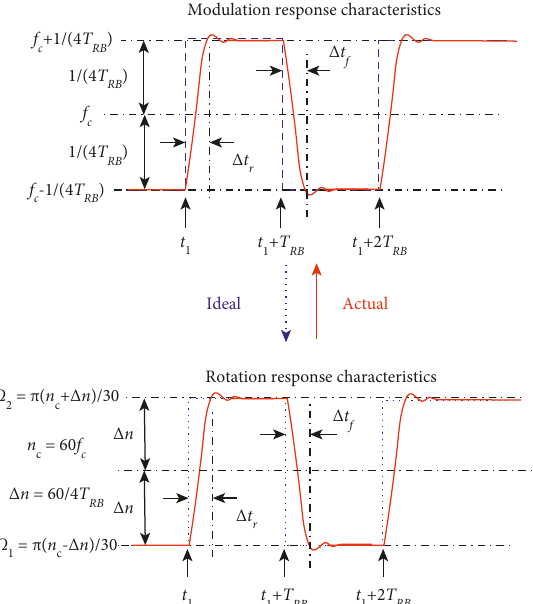
Figure 5: Speed step response of